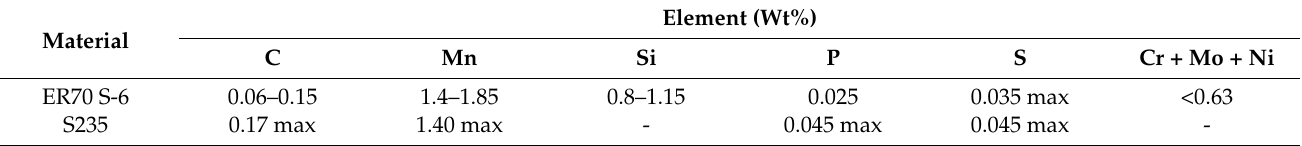
Table 3. Chemical composition of S235 and ER70S-6.